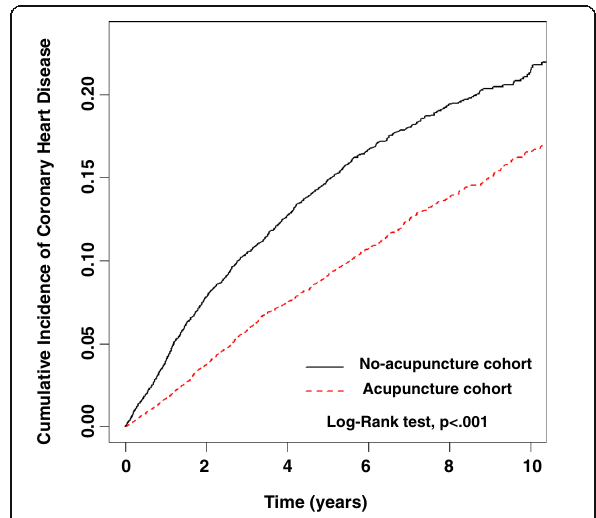
Fig. 3 Cumulative incidence of coronary heart disease (CHD) between the acupuncture and no-acupuncture cohorts. The cumulative incidence of coronary heart disease in the acupuncture cohort (dashed line) is significantly lower than the no-acupuncture cohort (solid line) (log-rank test, p < .001). The